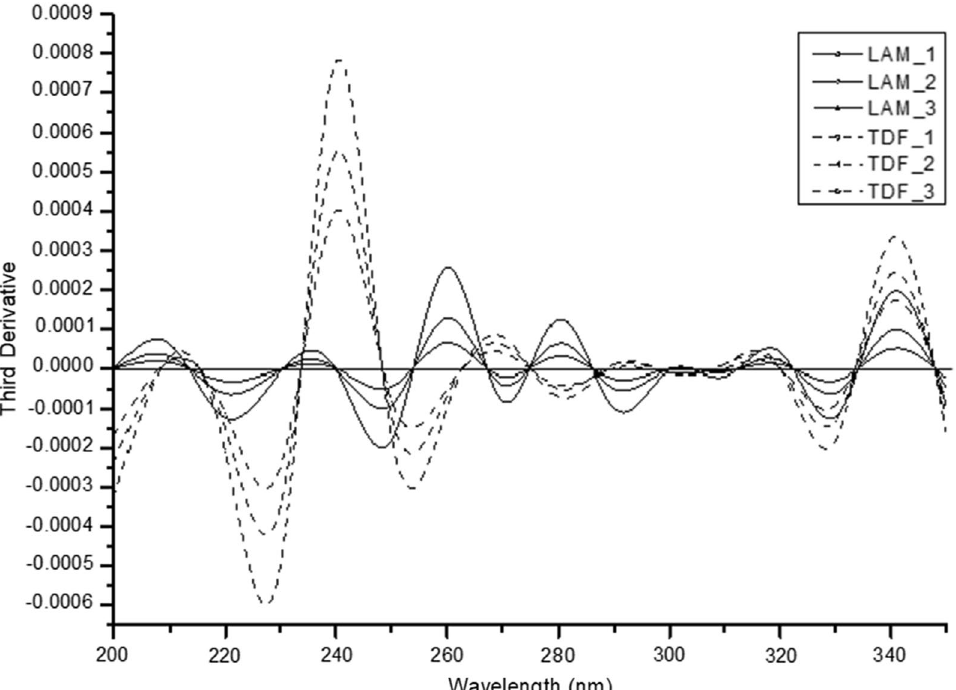
Fig. 4 Third-order derivative spectra of lamivudine (1) 2 µg mL − 1 , (2) 4 µg mL − 1 , (3) 6 µg mL − 1 and tenofovir disproxal fumarate (1) 16 µg mL − 1 , (2)